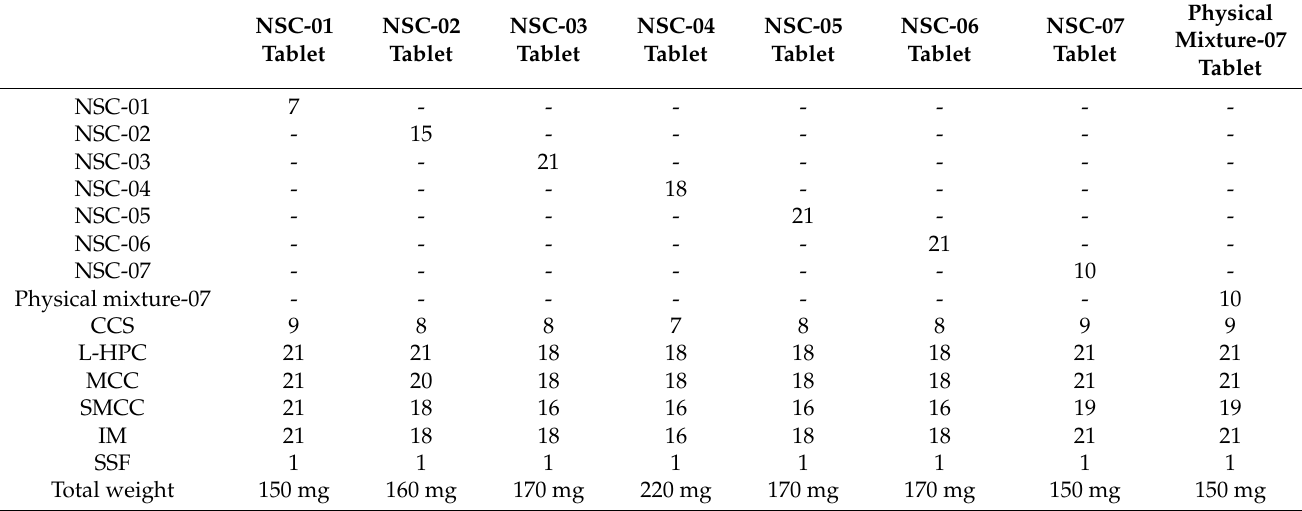
Table 2. Composition of NSC tablets (%, w / w